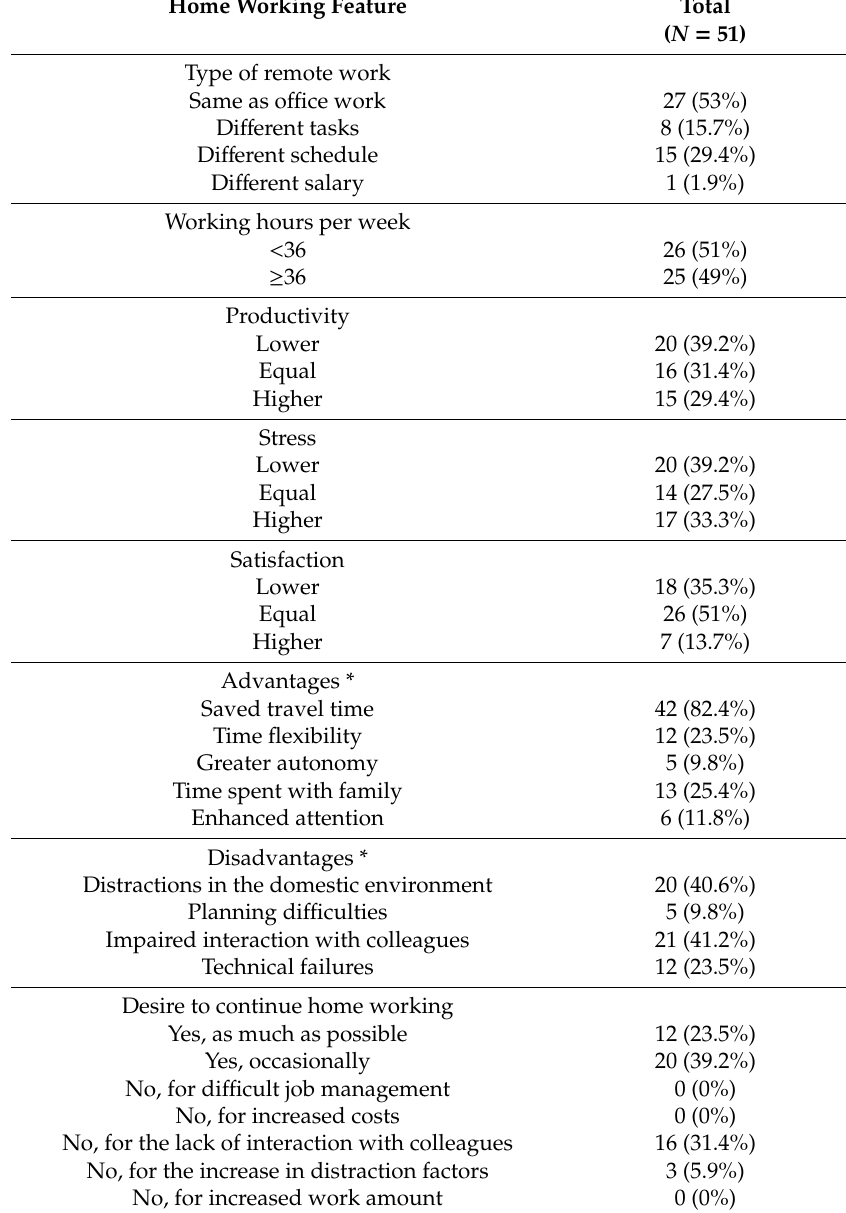
Table 2. Characteristics and quality of remote